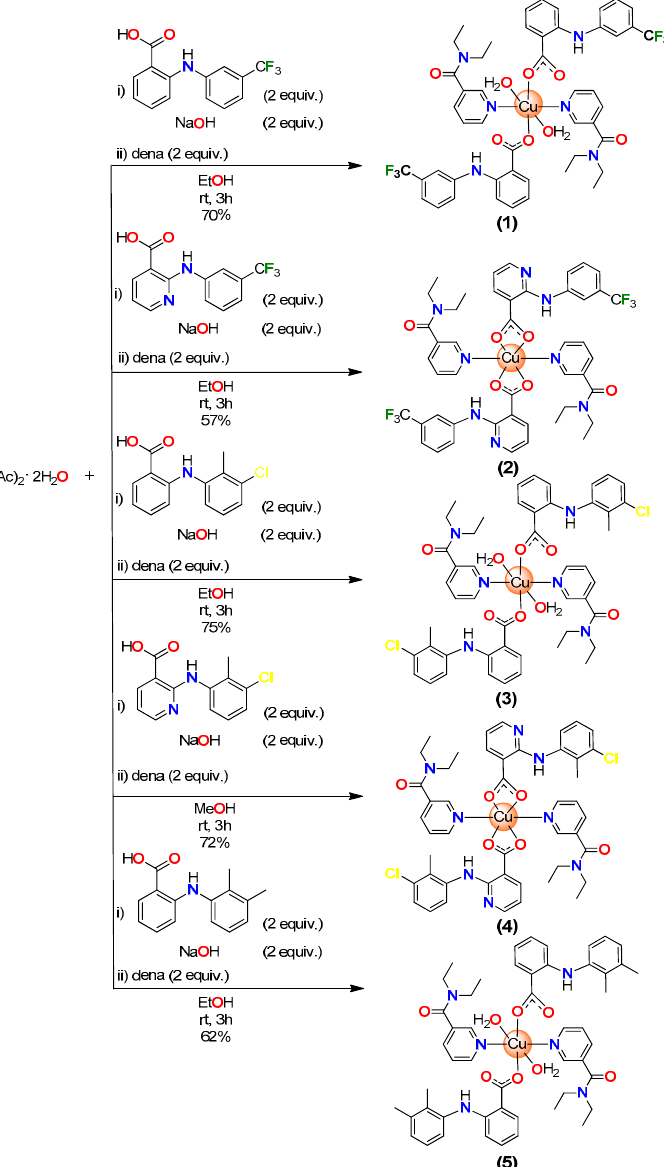
Scheme 2. Schematic representation of the syntheses of 1–5